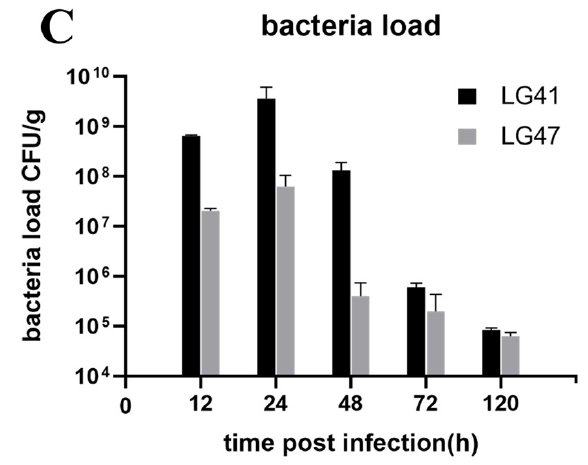
Figure 8. Pathological changes, histology, and bacterial load after mammary gland inoculation with L. garvieae in mice. ( A ) Pathological changes, including edema and hyperemia, in mammary glands of mice, challenged with two L. garvieae isolates (LG41 and LG47) and the control group. ( B ) Histological evaluation of mammary tissue (hematoxylin–eosin staining). L. garvieae provoked acute mastitis, with an increasing number of inflammatory cells (mainly neutrophils) infiltrated into the gland alveoli and interstitium of the mammary gland (black arrow) after infection, and connective tissue filled in the vacancy caused by inflammation after epithelial cell apoptosis (red arrow). CON = control. ( C ) Bacterial burden in mammary glands of mice (up to 120 h after inoculation). Each time point represents three mice in each of the five groups. There was no difference between L. garvieae isolates by ANOVA test. The bar charts were calculated and plotted using GraphPad prism 8.